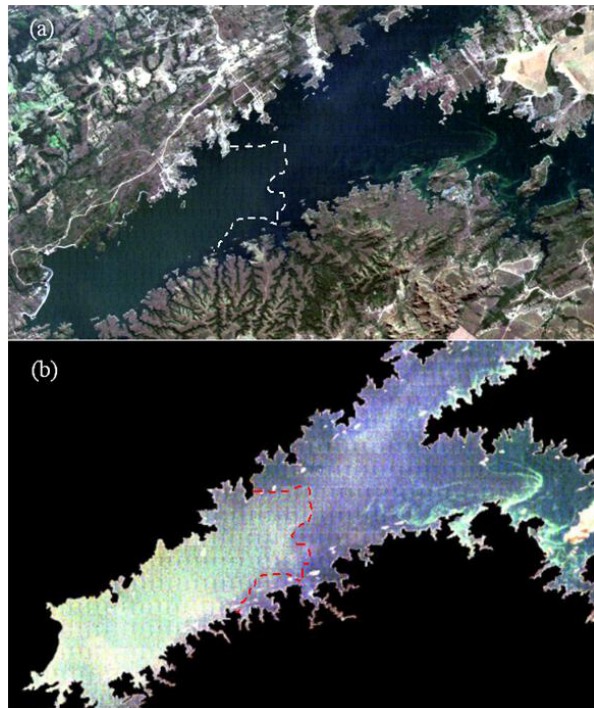
Figure 10: (a) Satellite imagery in a normal composition (RGB-321) showing the area with a chlorophyll bloom (from the left up to the dashed contour). (b) The same satellite imagery with a land mask and enhanced contrast to better discriminate the phytoplankton bloom (16 July 2007).